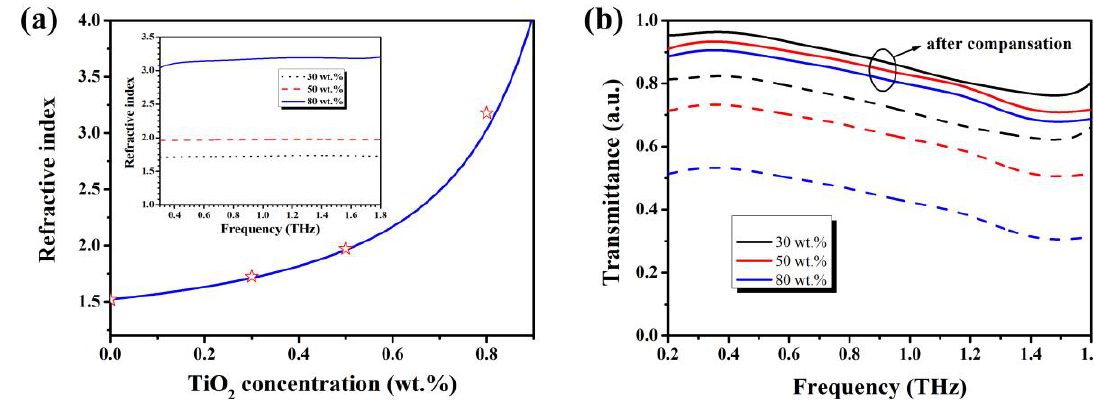
Figure 2. Optical properties of COP–TiO 2 composites. ( a ) Refractive indices of the composites as a function of the doping weight ratio; the inset shows the refractive index change as a function of frequency. ( b ) Transmittance spectra of the composites.